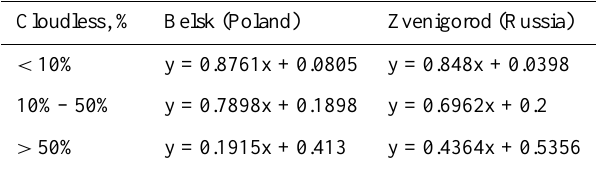
Table 1. Coefficients of the linear regression between AERONET data and the retrieved AOT values for different situations.